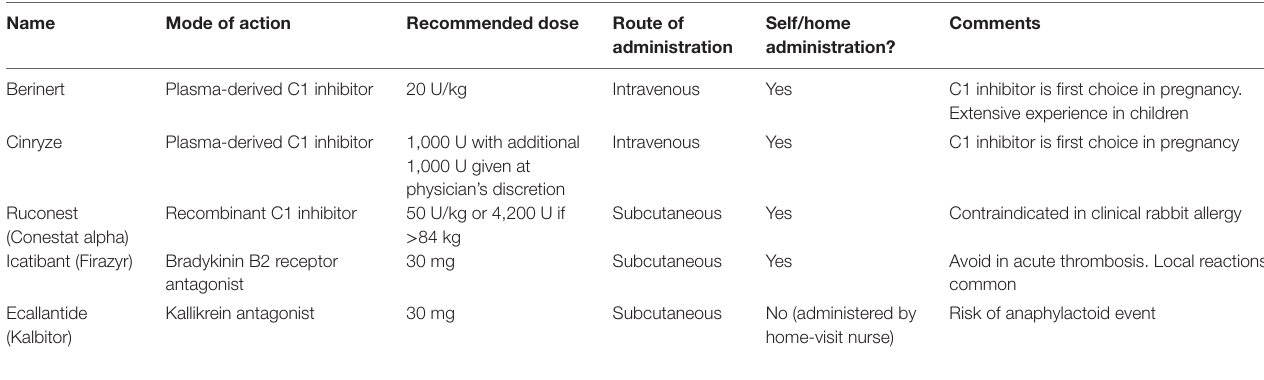
TABle 1 | Acute treatments for hereditary